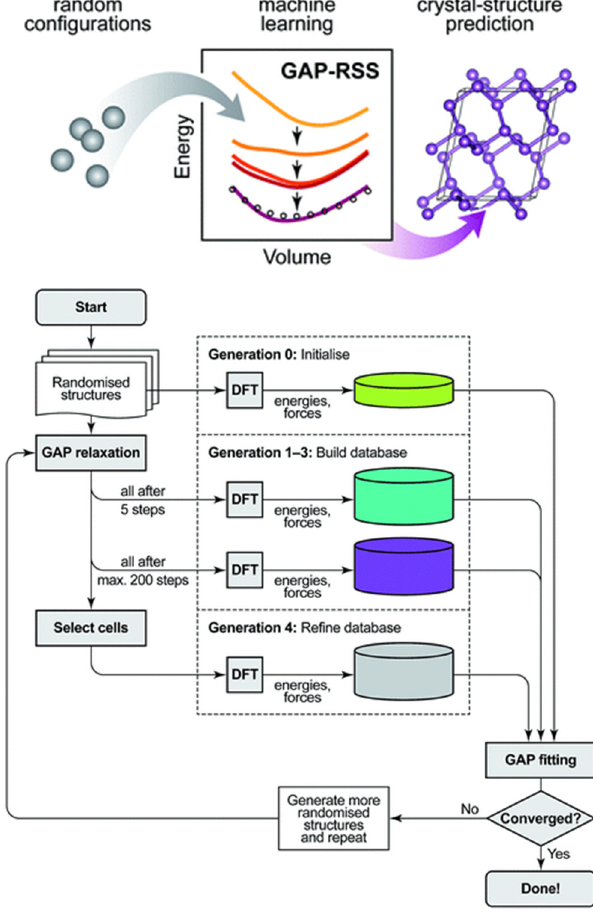
Figure 20. GAP-RSS (Gaussian approximation potential-based random structure searching) scheme and protocol [315].